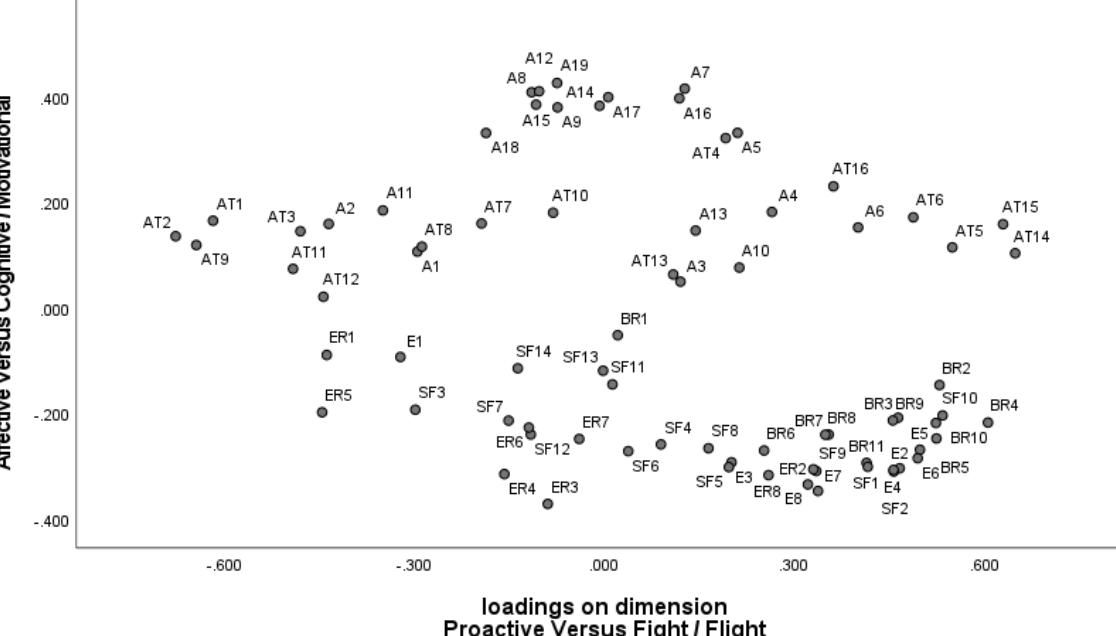
Figure 1. Plot of the loadings of the emotional reactions on the second and third dimension as a function of the emotion component to which they belong. A: appraisal; AT: action tendency; BR: bodily reaction; E: expression; SF: subjective feeling; ER: emotion